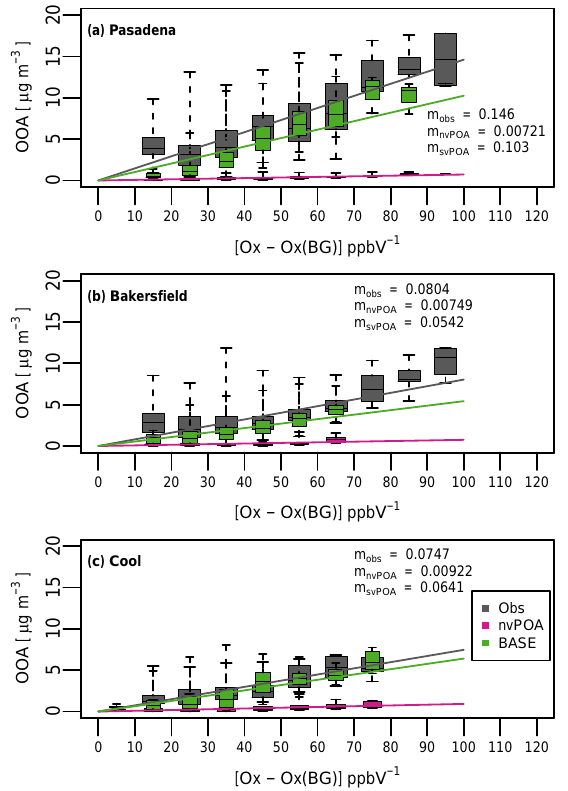
Figure 4. OOA concentrations (µgm − 3 ) at California sites as a function of the measured O x (O 3 + NO 2 ) concentration. A back- ground concentration, O x (BG), of 13.5ppbv is assumed, consis- tent with Hayes et al. (2015). The boxes behind each trend indi- cate the 25th and 75th percentiles of the data. The whiskers extend to the 10th and 90th percentiles. The solid horizontal lines in each box identify the median, and the solid curves indicate the means of each model run. Model values are projected to PM 1 to correspond roughly to the size cutoff of the